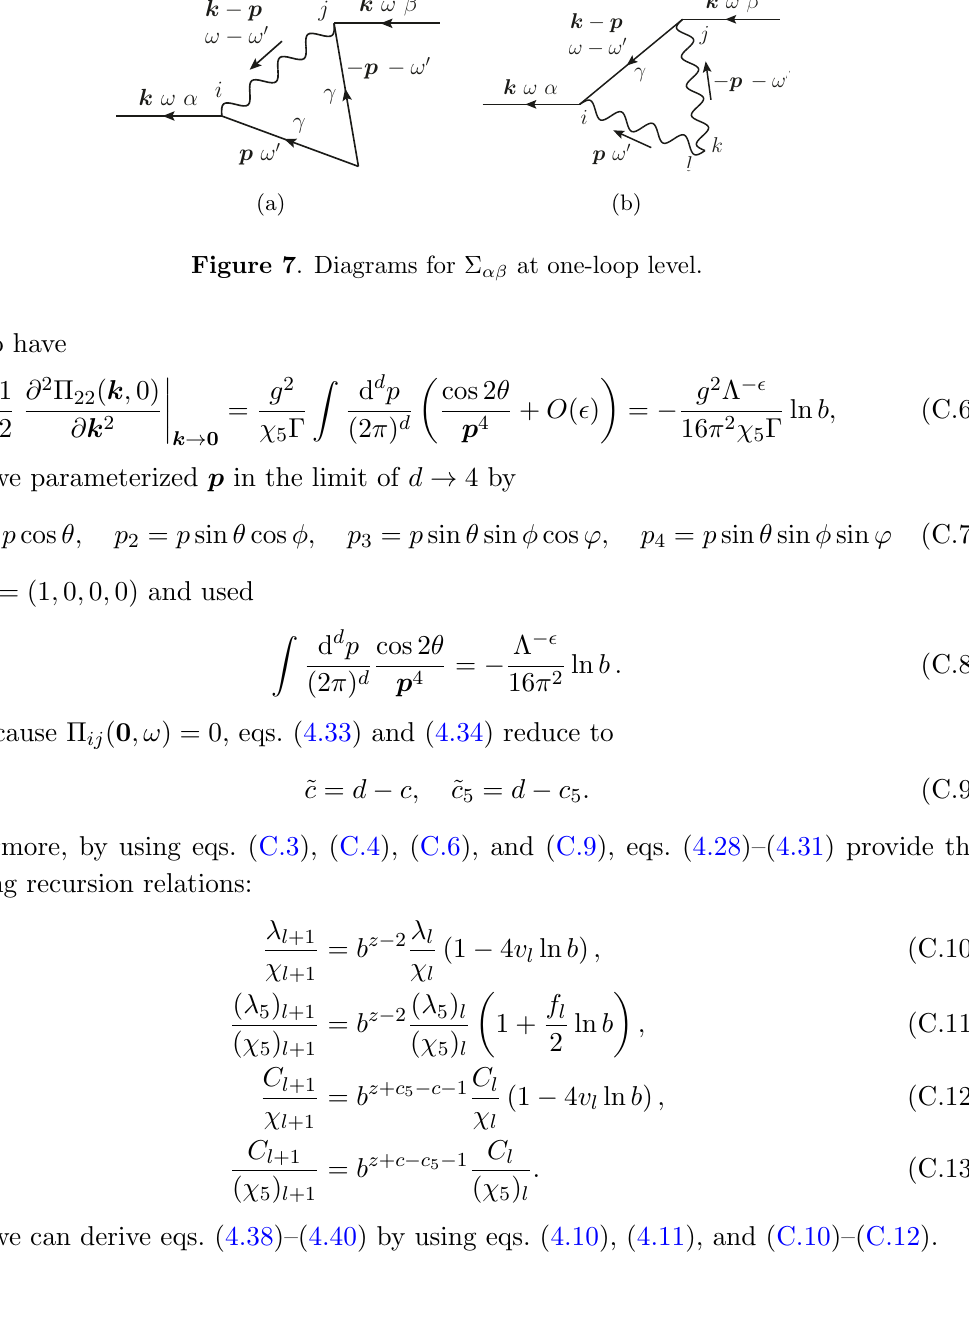
ij at one-loop level.